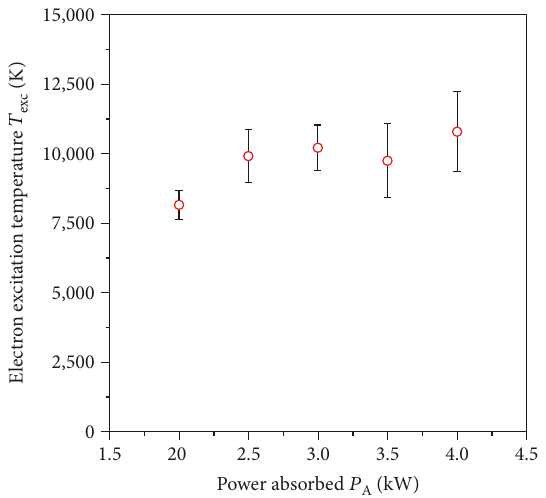
Figure 4: Electron excitation temperature as a function of absorbed . microwave power P A